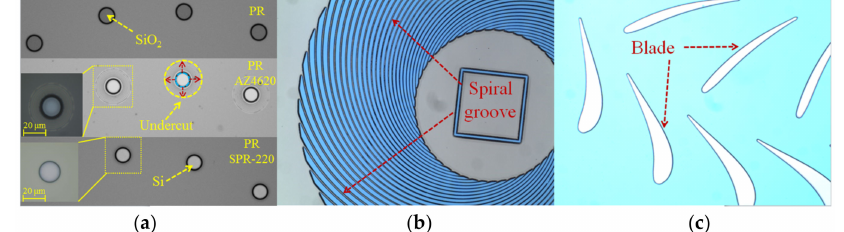
Figure 5. Wet etch result of typical structure in MABs with different masking and etching methods. ( a ) 20 µ m-diameter nozzles wet etched by traditional and novel method; and, ( b , c ) Patterns of spiral groove and blade etched using novel